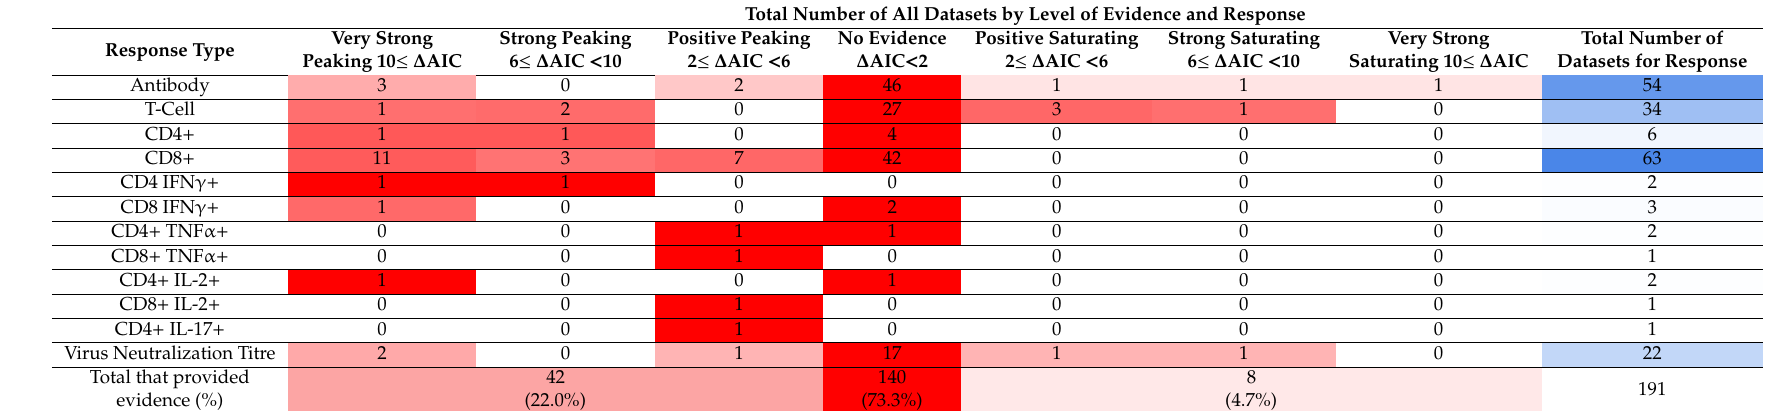
Table 1. Number of datasets for each level of evidence, sorted by response type.